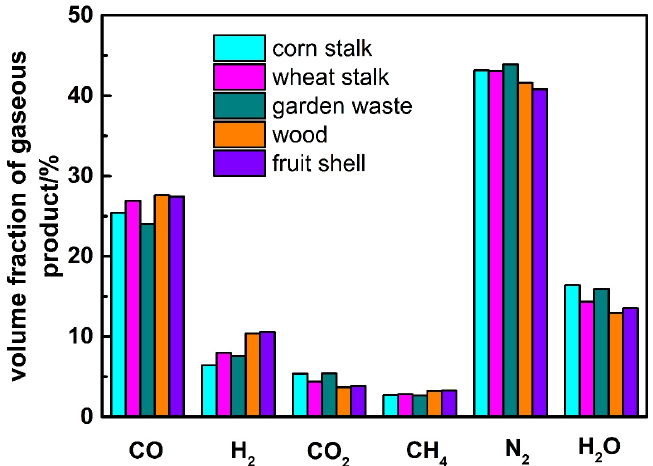
Figure 7. Effect of biomass types on gaseous product.